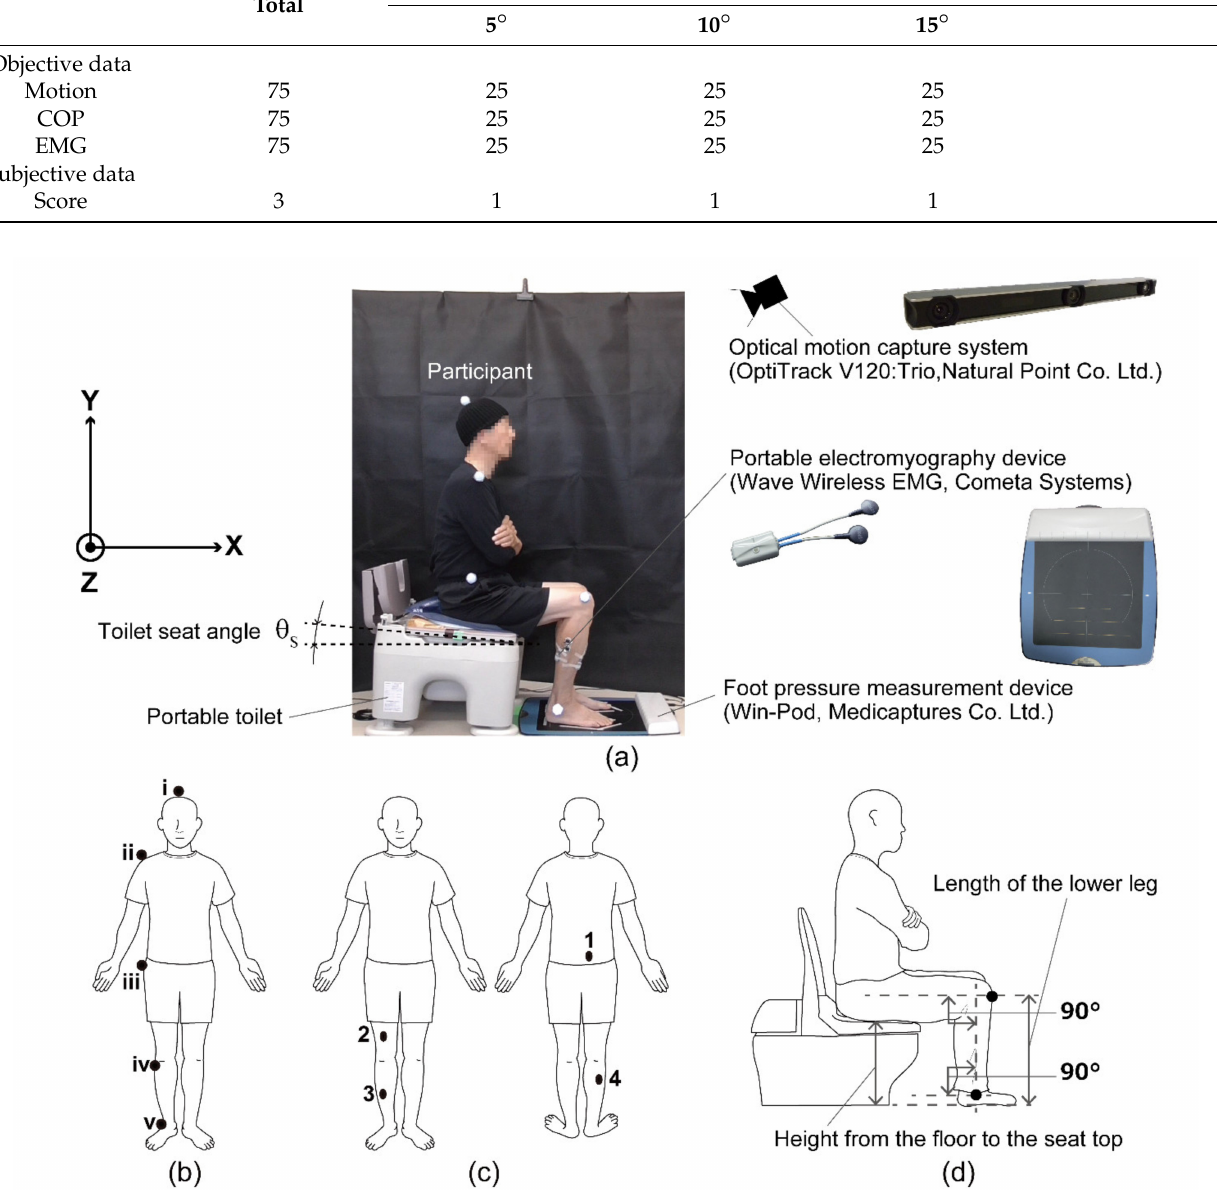
Figure 1. ( a ) Schematic diagram of the experimental setup. ( b ) Location of the body motion measurement markers. ( c ) Location of the electromyography (EMG) signal measurement electrodes. ( d ) Reference posture for the standing-up motion from the toilet seat (with a toilet seat angle of 0 ◦